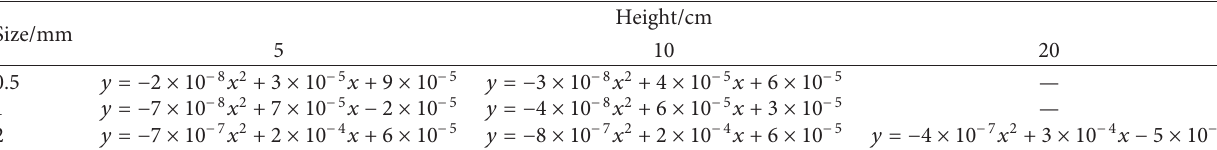
Table 6: Numerical simulation fitting